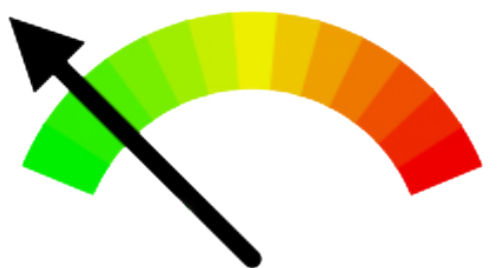
Figure 1. An example of a Google-o-Meter widget.